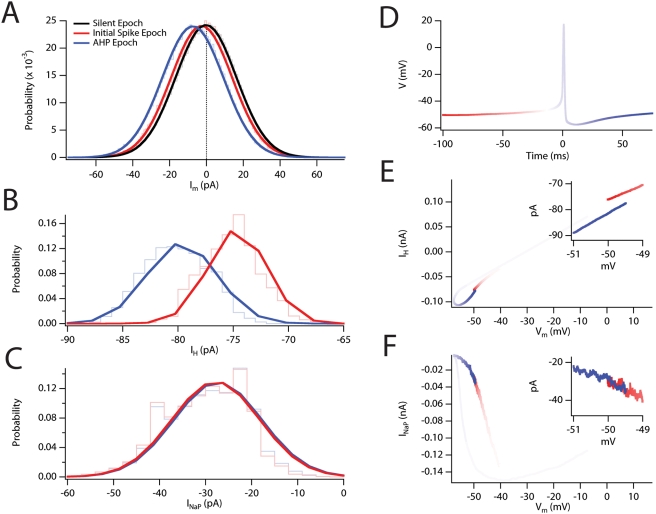
Ih during AHP recovery enhances spike probability and
clustering.(A) Probability density plots for the magnitude of the net ionic current
within the voltage range −49.5 to −50.5 mV taken
from epochs in which no action potentials occurred
(“Silent”; black), preceding the initial spike of a
cluster (“Initial Spike”; red), or, during recovery
from the spike AHP (“AHP”; blue). Each plot is fit
with a Gaussian function, which was used to estimate the standard
deviation of the distribution. Areas were normalized to
P = 1 and all distributions had nearly
identical properties
(σsteady-state = 16.6
pA, σAHP = 16.6 pA,
σsilence = 16.5
pA). (B–C) Probability density plot for Ih (B) and
for INaP (C) during the same simulation epoch as in A. (D)
Color-coded plot of the average membrane potential for all action
potentials. Transition from red to blue color applies to E and F. Solid
lines are derived from fits of Gaussian functions. (E) Phase plot of the
mean Ih during the spike. (F) Phase plot of the mean
INaP during the spike. (E–F) Insets focus in on
the region of membrane potential selected for the plots in
A–C.